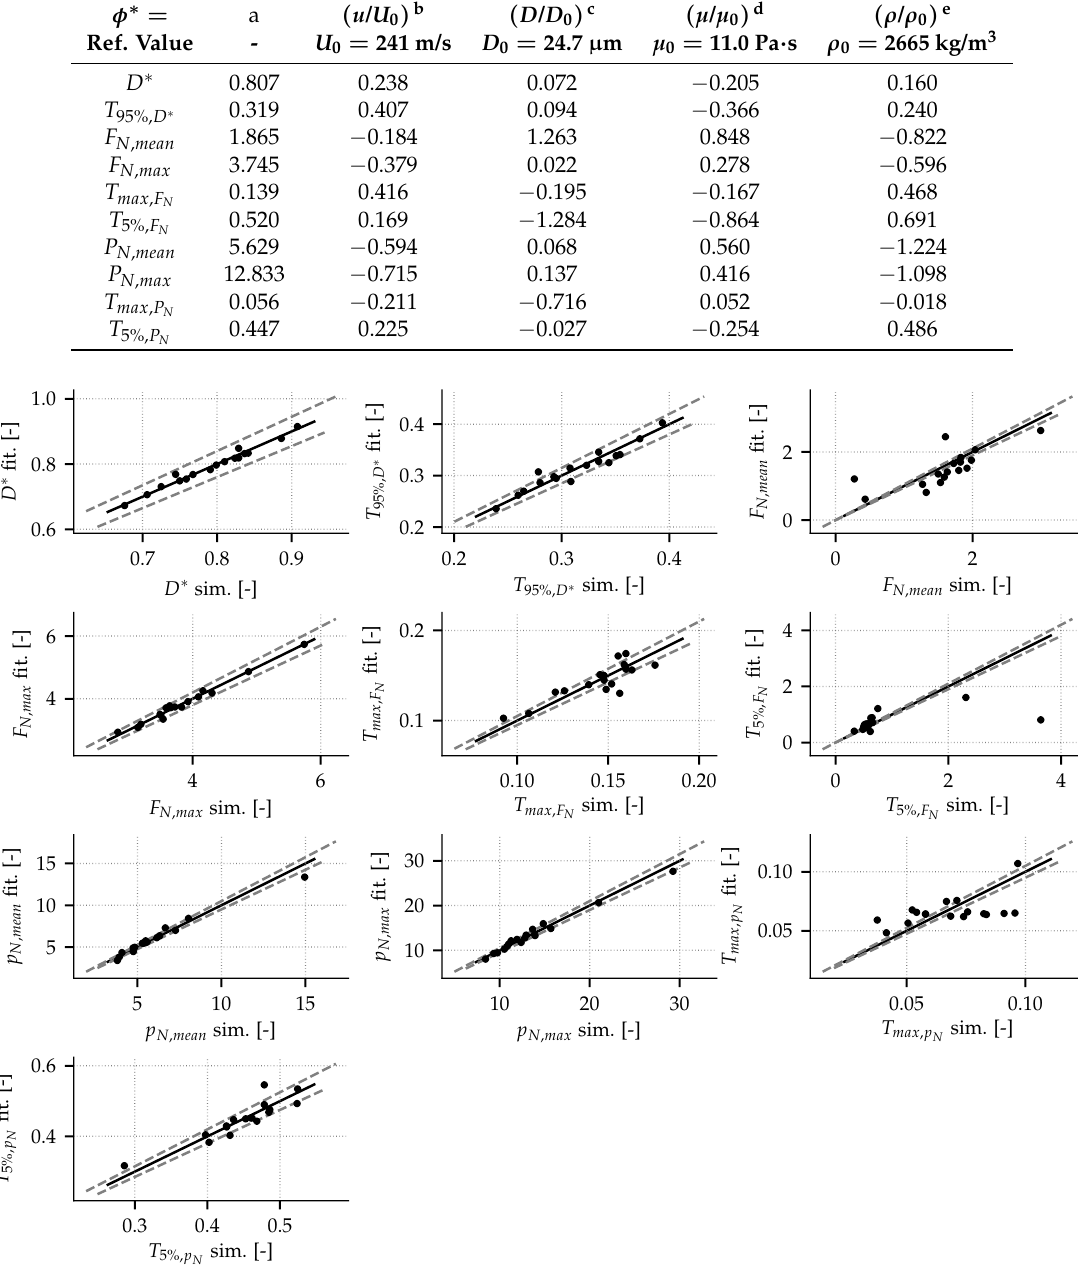
Figure 10. Comparison of correlations from Table 4 with the values extracted from the numerical